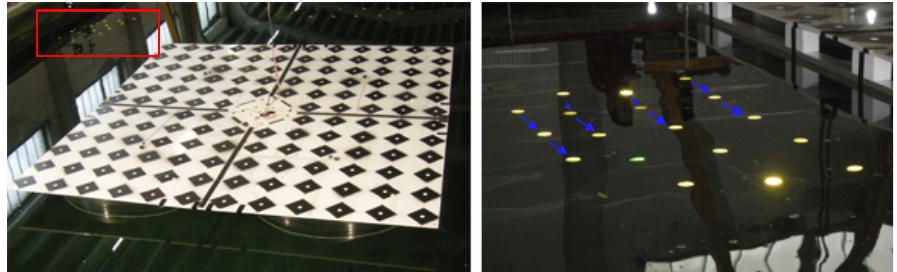
Figure 2. Left: physical, retro-reflective targets floating in the vicinity of the platform are marked with the red box. Right: a close-up of the targets; the arrows indicate established cluster pairs.